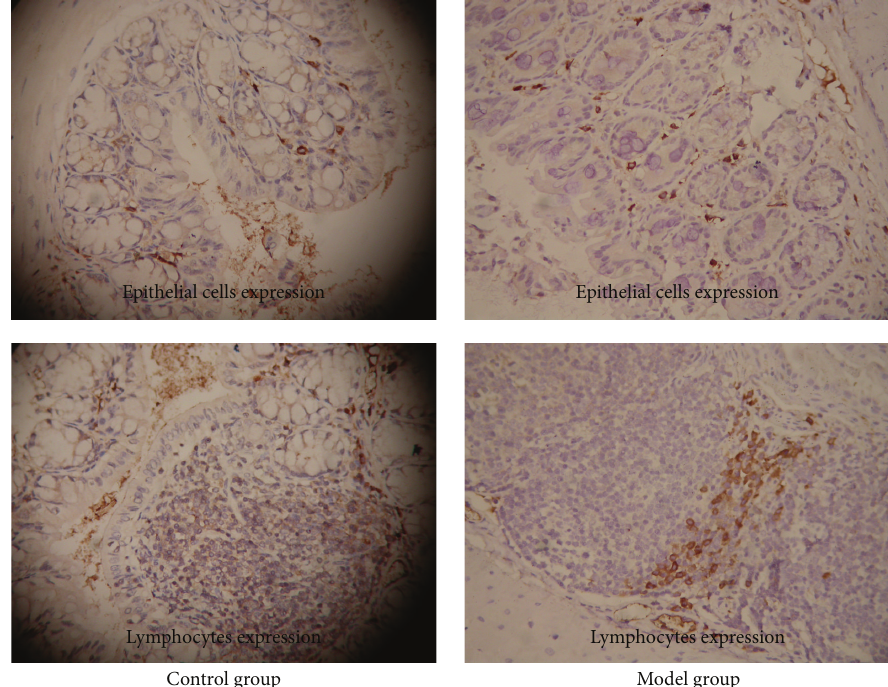
Figure 3: The colonic mucosal Flt3 expression in the control and UC model group. Immunohistochemistry showed that Flt3 was expressed in colonic epithelial cells and colonic lymphocytes. Expression of Flt3 protein in the colonic mucosa in the model group was significantly lower than that in the control group ( 31.66 ± 2.31 versus 82.19 ± 5.34 , 𝑃 < 0.05 ).